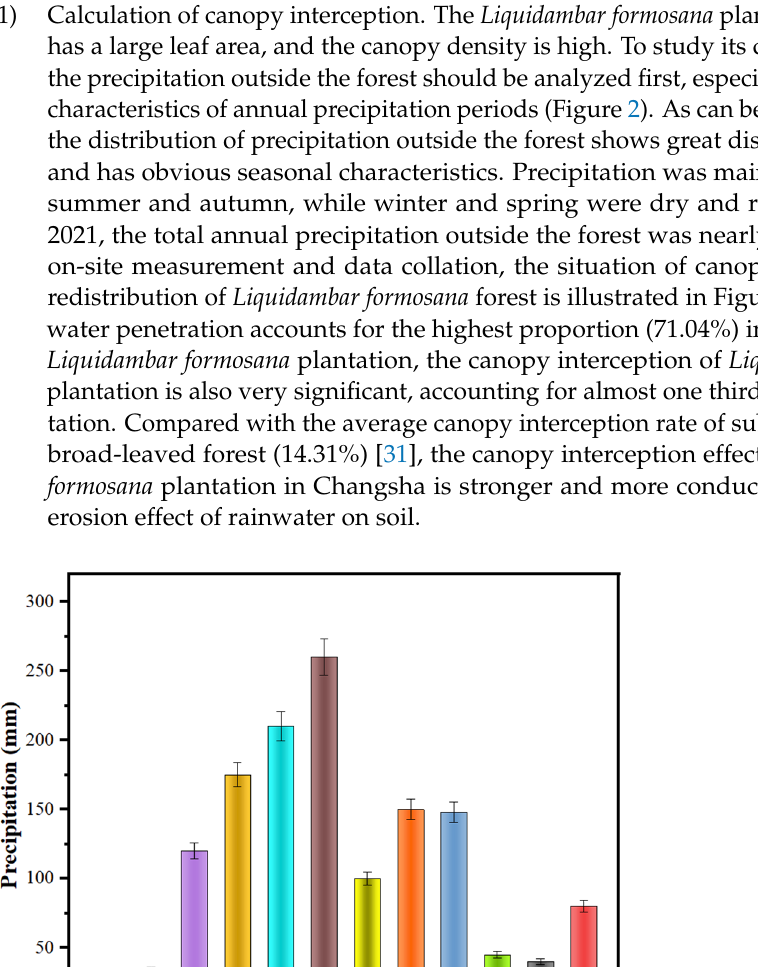
Figure 3. Canopy precipitation redistribution in Liquidambar formosana plantation . (2) Calculation of litter water holding capacity. The water holding capacity of forest litter is closely related to its storage. According to Zhang Xi et al.’s (2018) statistical data on litter reserves of the Liquidambar formosana plantation [21] (Table 4), the total dry weight of litter layer reserves of the Liquidambar formosana plantation is 4028.215 kg·hm − 2 . The water absorption capacity of the litter on the forest land surface can be measured on the spot. Combined with the known total dry weight of the litter layer reserves, the water holding capacity of the litter can be calculated (Table 5). The litter layer plays a very important role in the water conservation of forests, which can trap atmospheric precipitation and block surface runoff and scour. At the same time, the decomposition of litter forms soil humus, which can significantly improve soil struc- ture and soil permeability. Table 4. Litter layer storage [21] . Plot